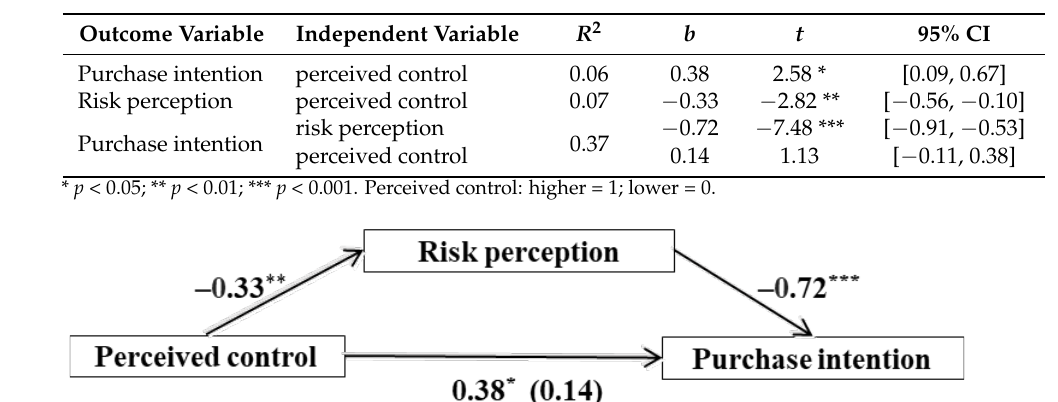
Table 4. Study 2 mediation effects analyses ( N = 115).